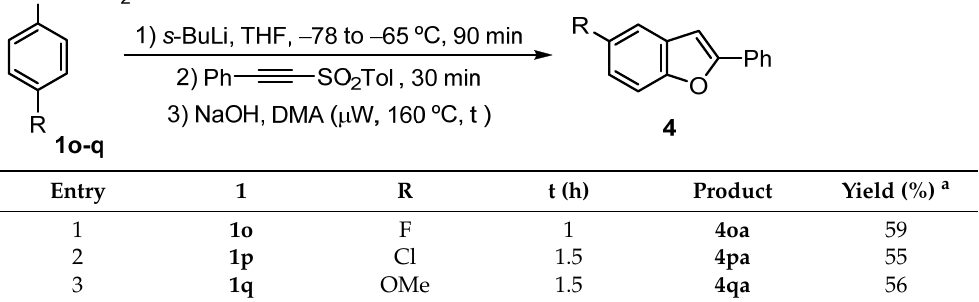
Table 4. Synthesis of 5-functionalized benzo[ b ]furans 4 from carbamates 1o-q .